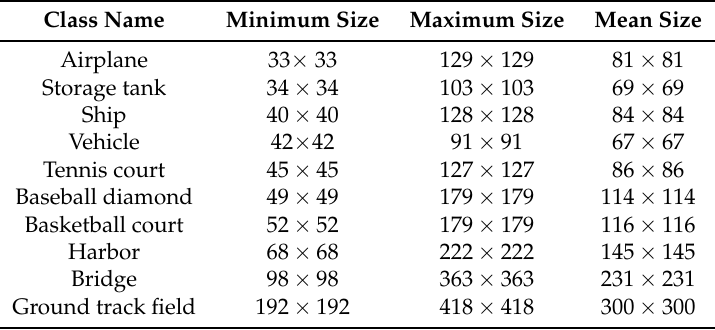
Table 1. The statistics of object size in the NWPU VHR-10 dataset. Class Name Minimum Size Maximum Size Mean Size Airplane 33 ×